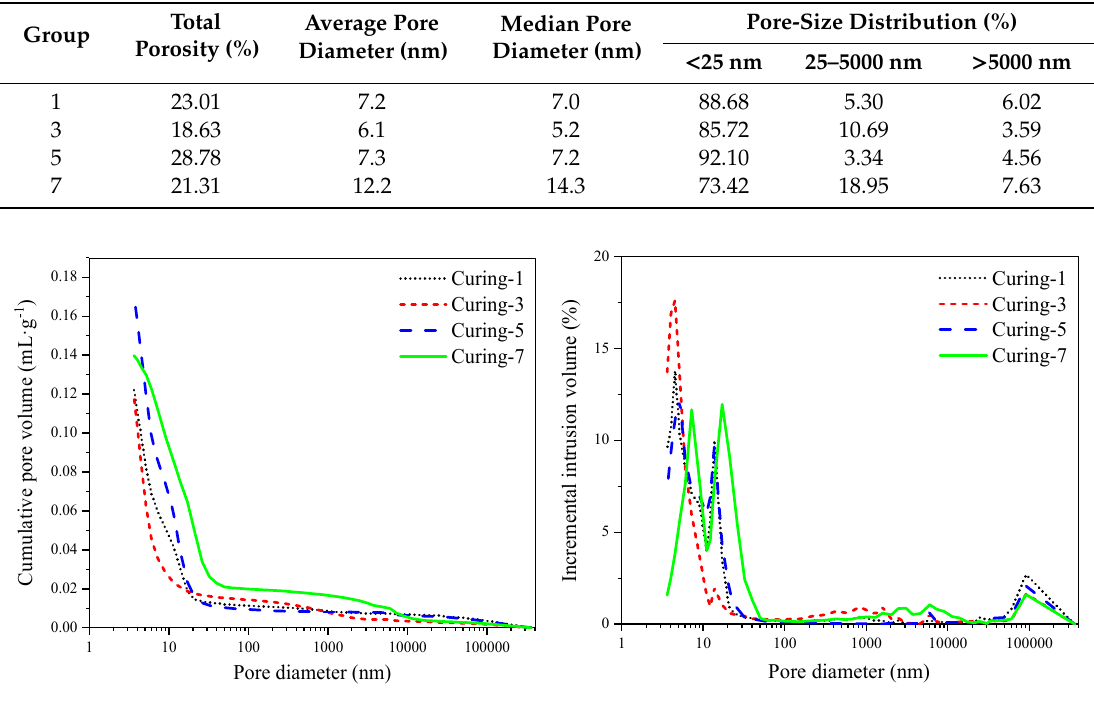
Figure 8. Effect of early curing on pore structure of AAS pastes. Figure 8. E ff ect of early curing on pore structure of AAS